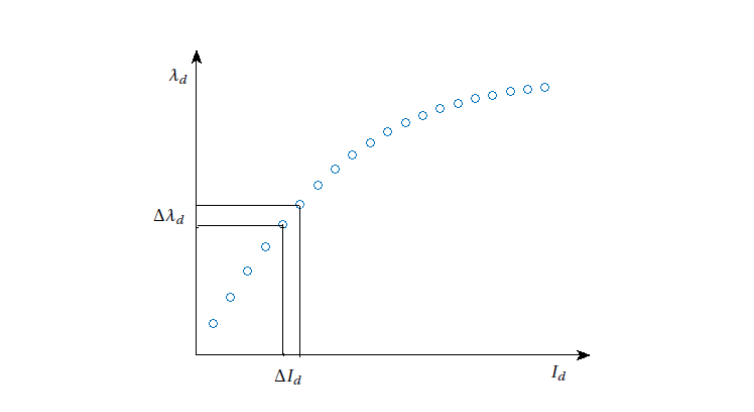
Figure 5. Calculation for incremental inductance